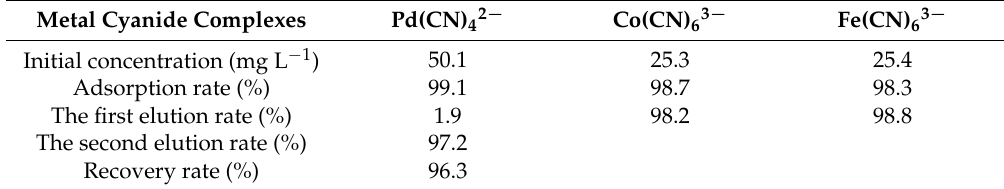
Table 6. Adsorption and separation of metal cyanide complexes from mixed